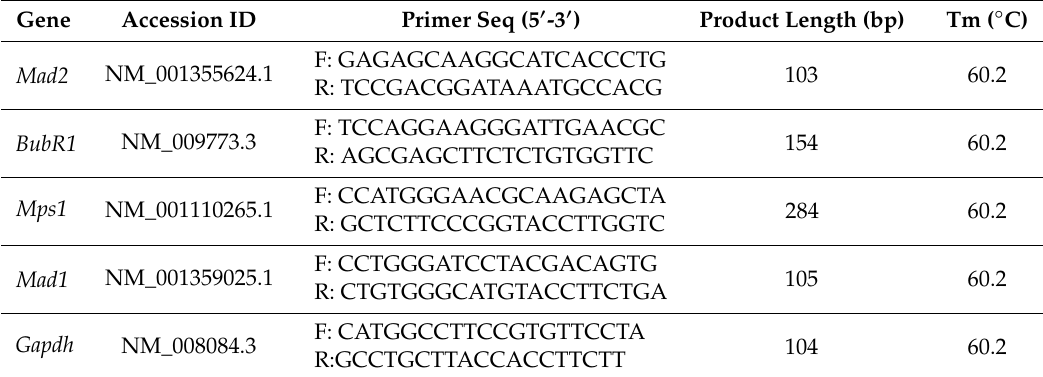
Table 1. PCR primers used for SYBR green Q-PCR